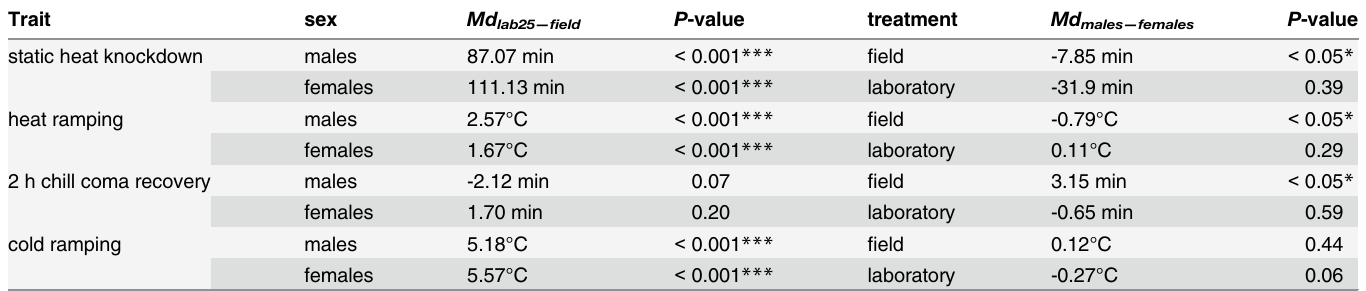
Table 1. Thermal tolerance analysis.